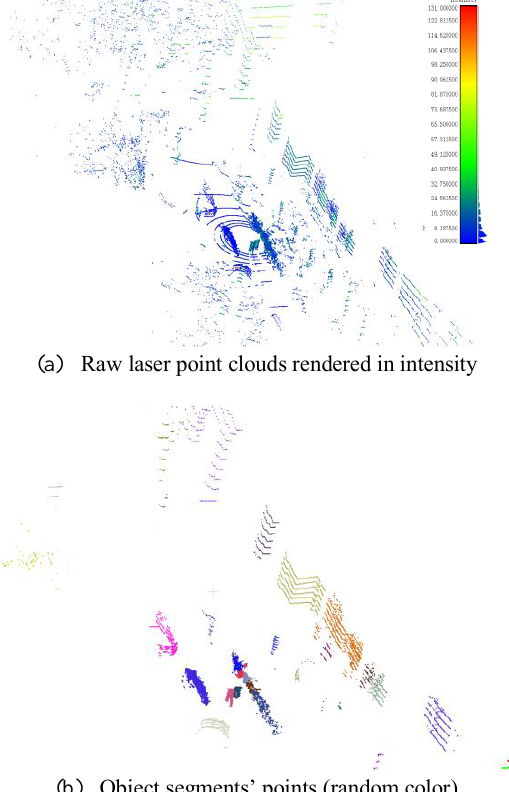
Figure 1. Illustration of the point cloud segmentation